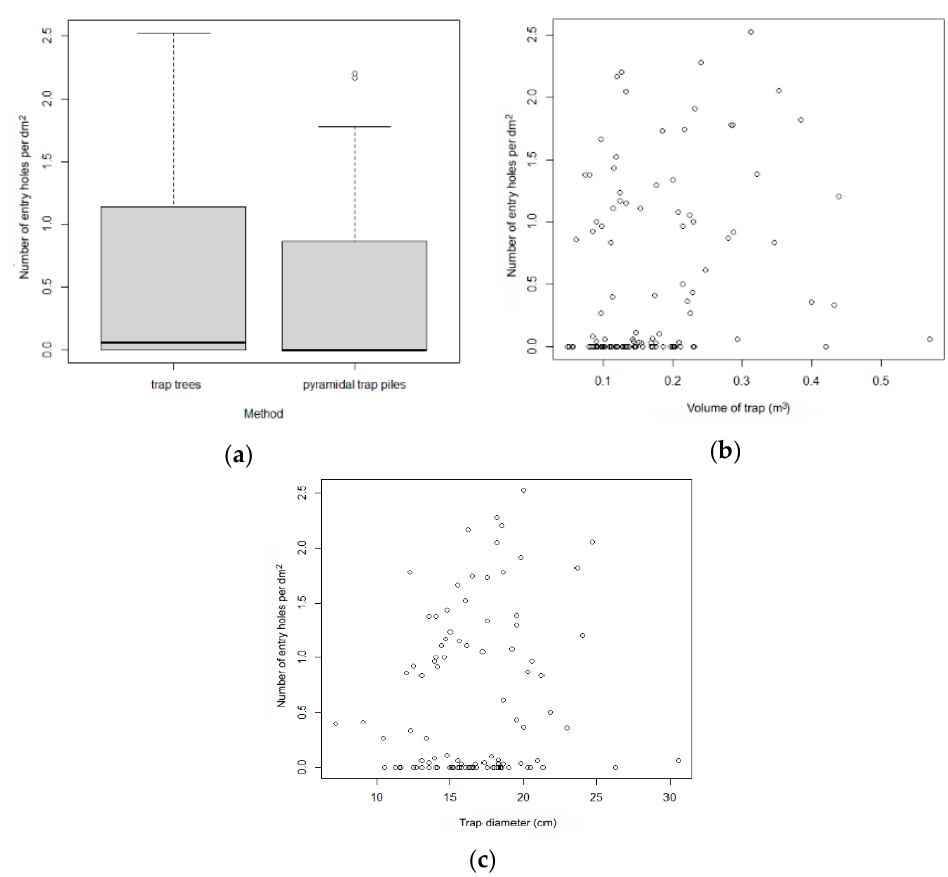
Figure 6. Number of entry holes as affected by trap type (trap trees vs. pyramid-trap piles) ( a ), wood volume ( b ), and wood diameter ( c ) in experiment 2. For trap type, the boxes indicate medians and interquartile range, the whiskers indicate minimum and maximum values, and circles indicate outliers.